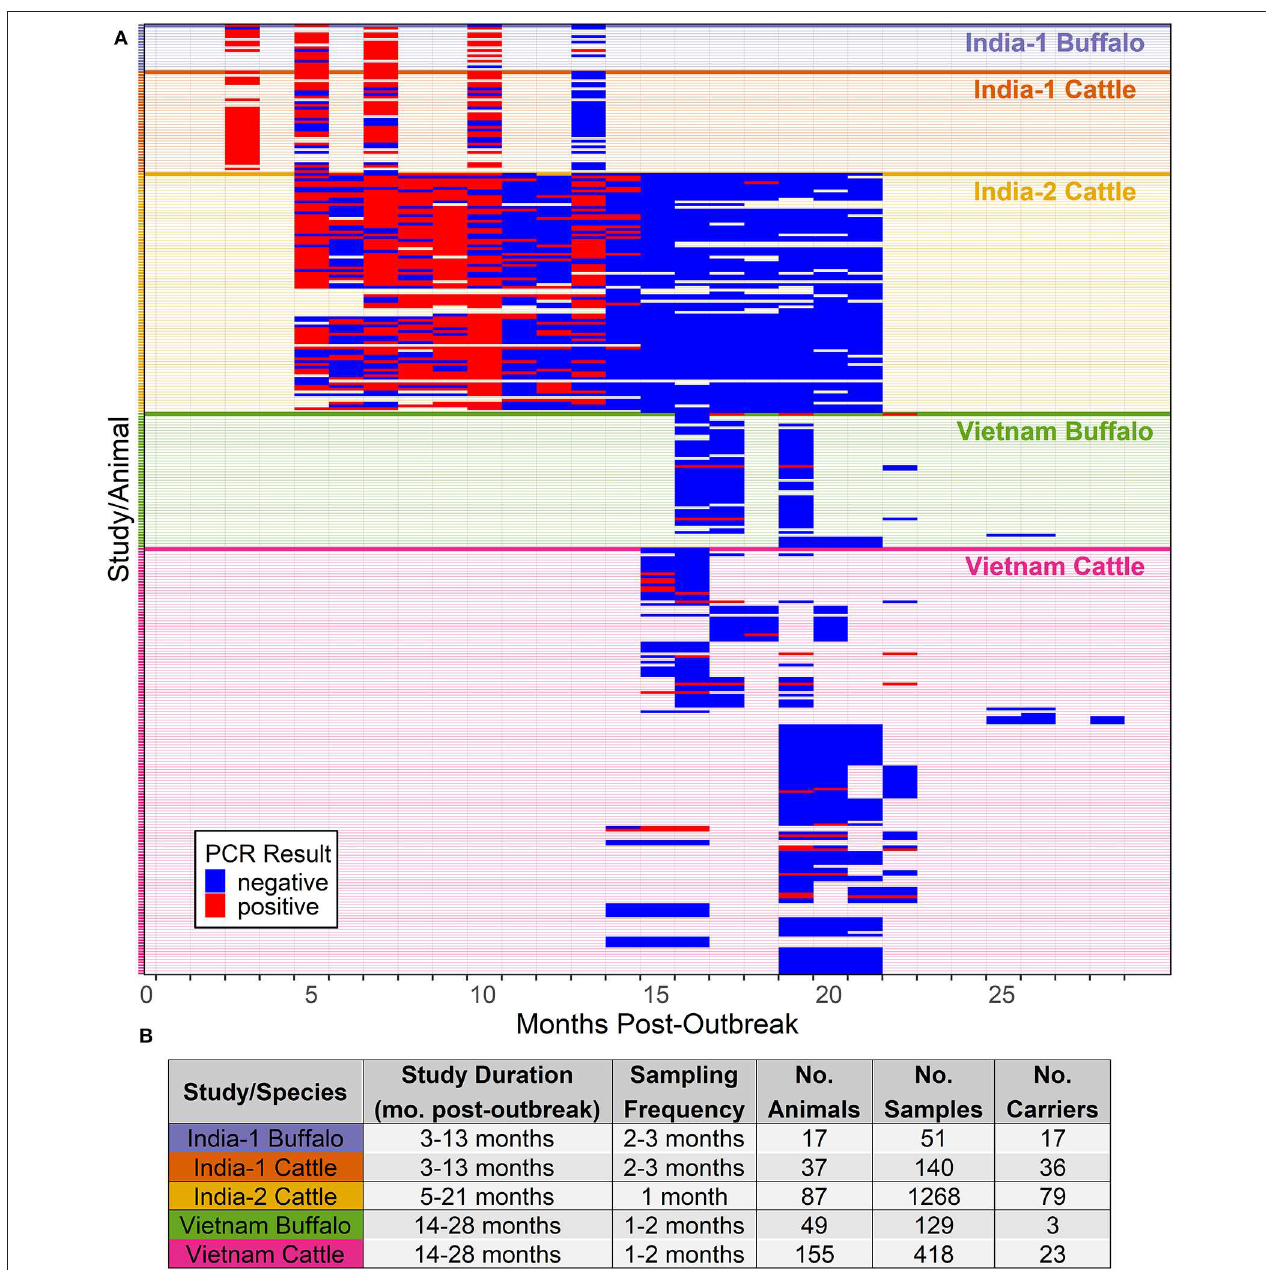
FIGURE 1 | FMDV RNA detection in oropharyngeal fluid by rRT-PCR. Data are presented from two studies in India and one in Vietnam, and include samples from cattle and Asian buffalo. (A) Each row represents one animal and the grouping of rows is colored according to study/species group. Study/species group is labeled on the right side of the figure and colored corresponding to the study/species in the table in (B) . Columns represent sampling times (months post-outbreak), and samples are represented by red (positive) and blue (negative) bars. (B) A summary of the data is provided in the